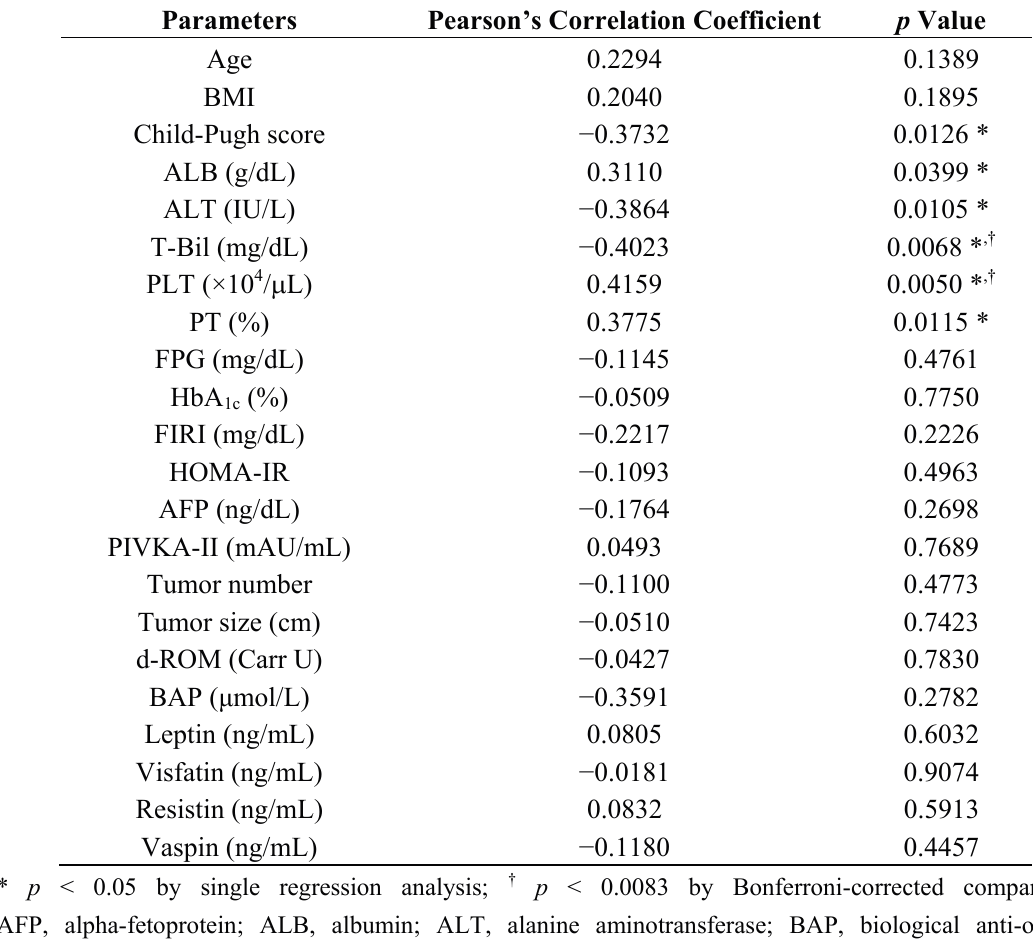
Table 2. Correlation of the serum chemerin level with various laboratory data by Pearson regression analysis.